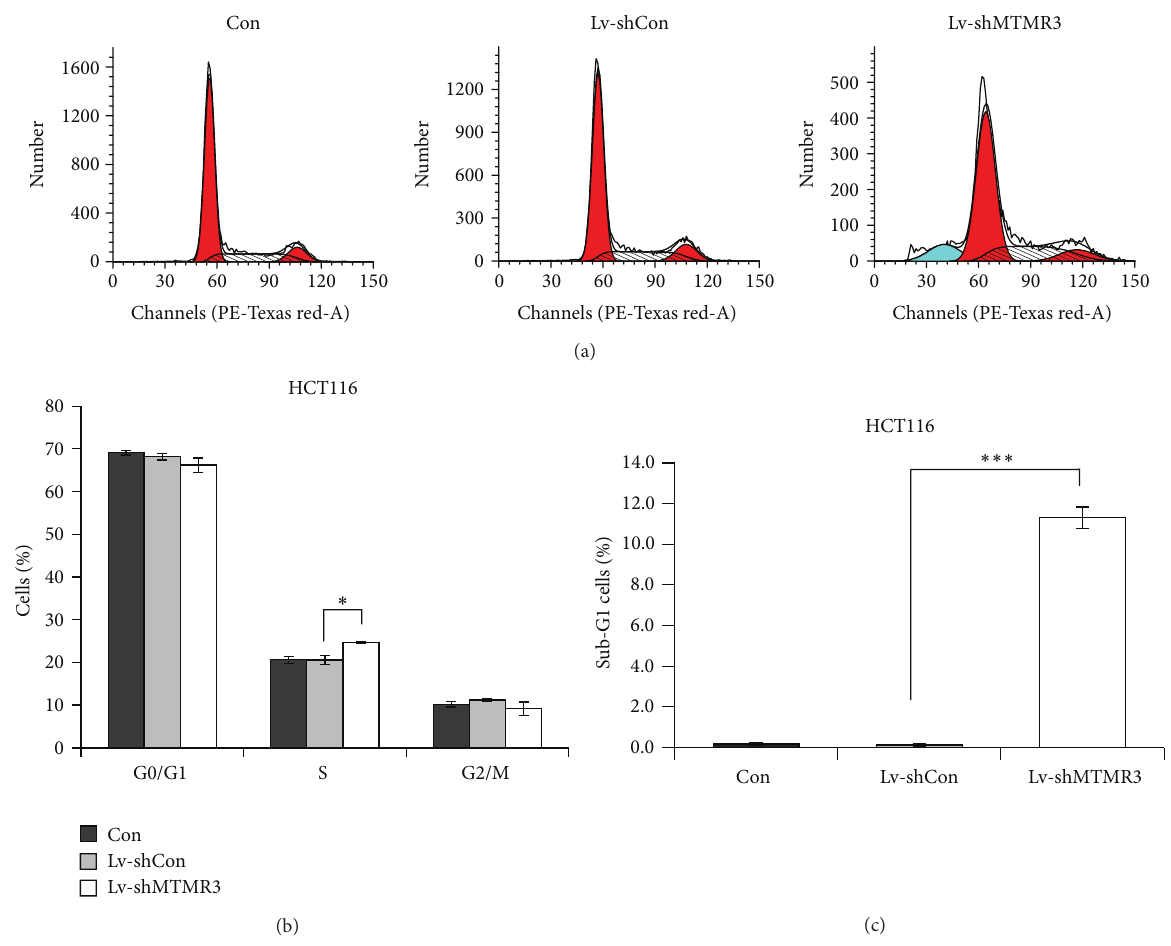
Figure 3: Lentivirus-mediated knockdown of MTMR3 blocks the cell cycle progression of HCT116 cells. (a) Cell cycle distribution of HCT116 cells with three treatments (Lv-shMTMR3, Lv-shCon, and Con) analyzed by flow cytometry using PI staining. The experiment was performed in triplicate and repeated three times. (b) The respective proportion of HCT116 cells in the G0/G1 phase, S-phase, and G2/M phase. (c) The respective proportion of HCT116 cells in the sub-G1 phase. ( ∗ 𝑃 < 0.05 , ∗∗∗ 𝑃 < 0.001